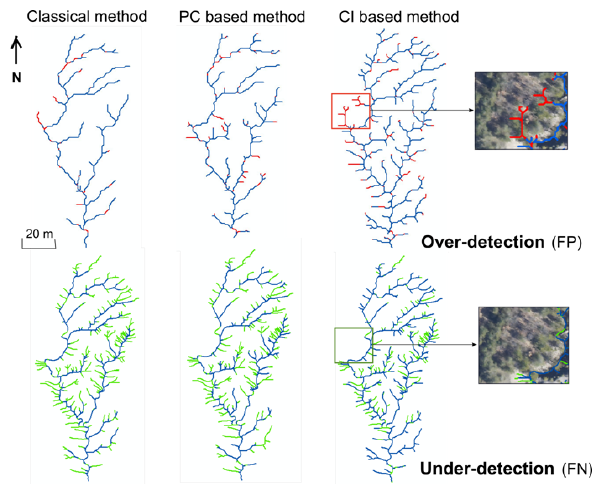
Figure 7. Comparison of over- and under-detection for the networks extracted using the three 2 Fig. 7. Comparison of over- and under-detection for the networks different methods; the Moulin catchment test area. 3 extracted using the three different methods; the Moulin catchment test